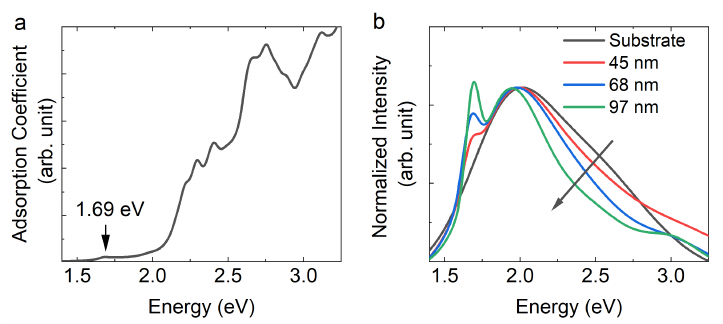
Figure 8. ( a ) The calculated absorption coefficient of bulk GeS, obtained averaging over the three components of the dielectric tensor. ( b ) The CL spectra reported in Figure 2 after normalization with respect to the maximum intensity of the broad peak at ~2